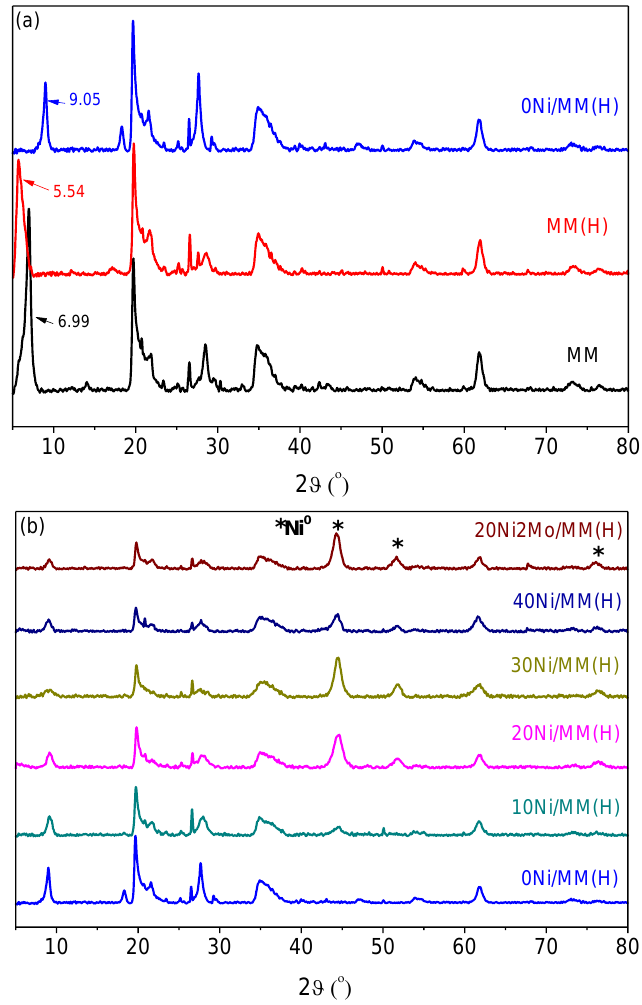
Figure 4. XRD patterns of the samples (( a ) supports and ( b ) catalysts).